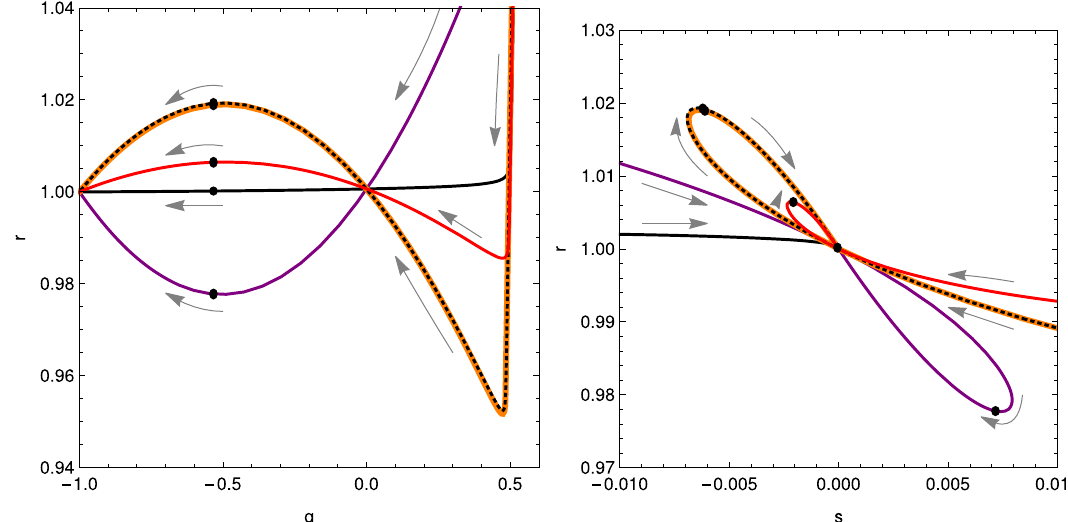
Fig. 13 The figure shows the planes r − q (left) and r − s (right) for the models Γ 2 T and Γ 1 c in the case α = − 0 . 01 and models Γ 2 c and Γ 2 d in the case α = 0 . 01. Black dots indicate current values and gray arrows